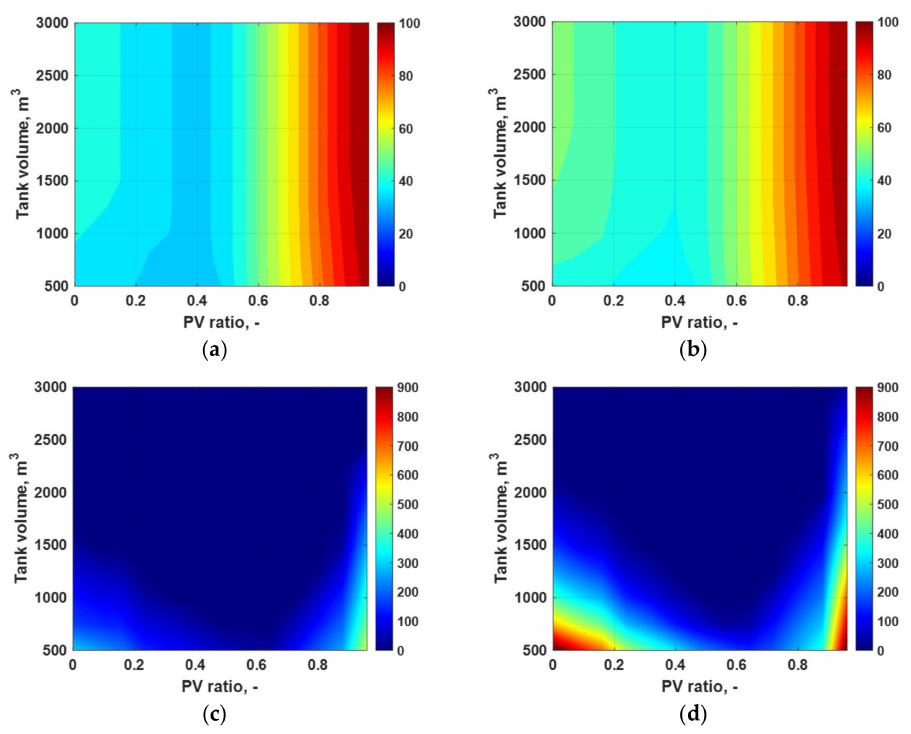
Figure 14. Variation of SCR (%) and WEE (kWh) for wine grapes and cherries for Sandanski, with a 12.5 kW HRES, with pSi PV panels and WT type 3: ( a ) SCR for wine grapes; ( b ) SCR for cherries; ( c ) WEE for wine grapes; ( d ) WEE for cherries.